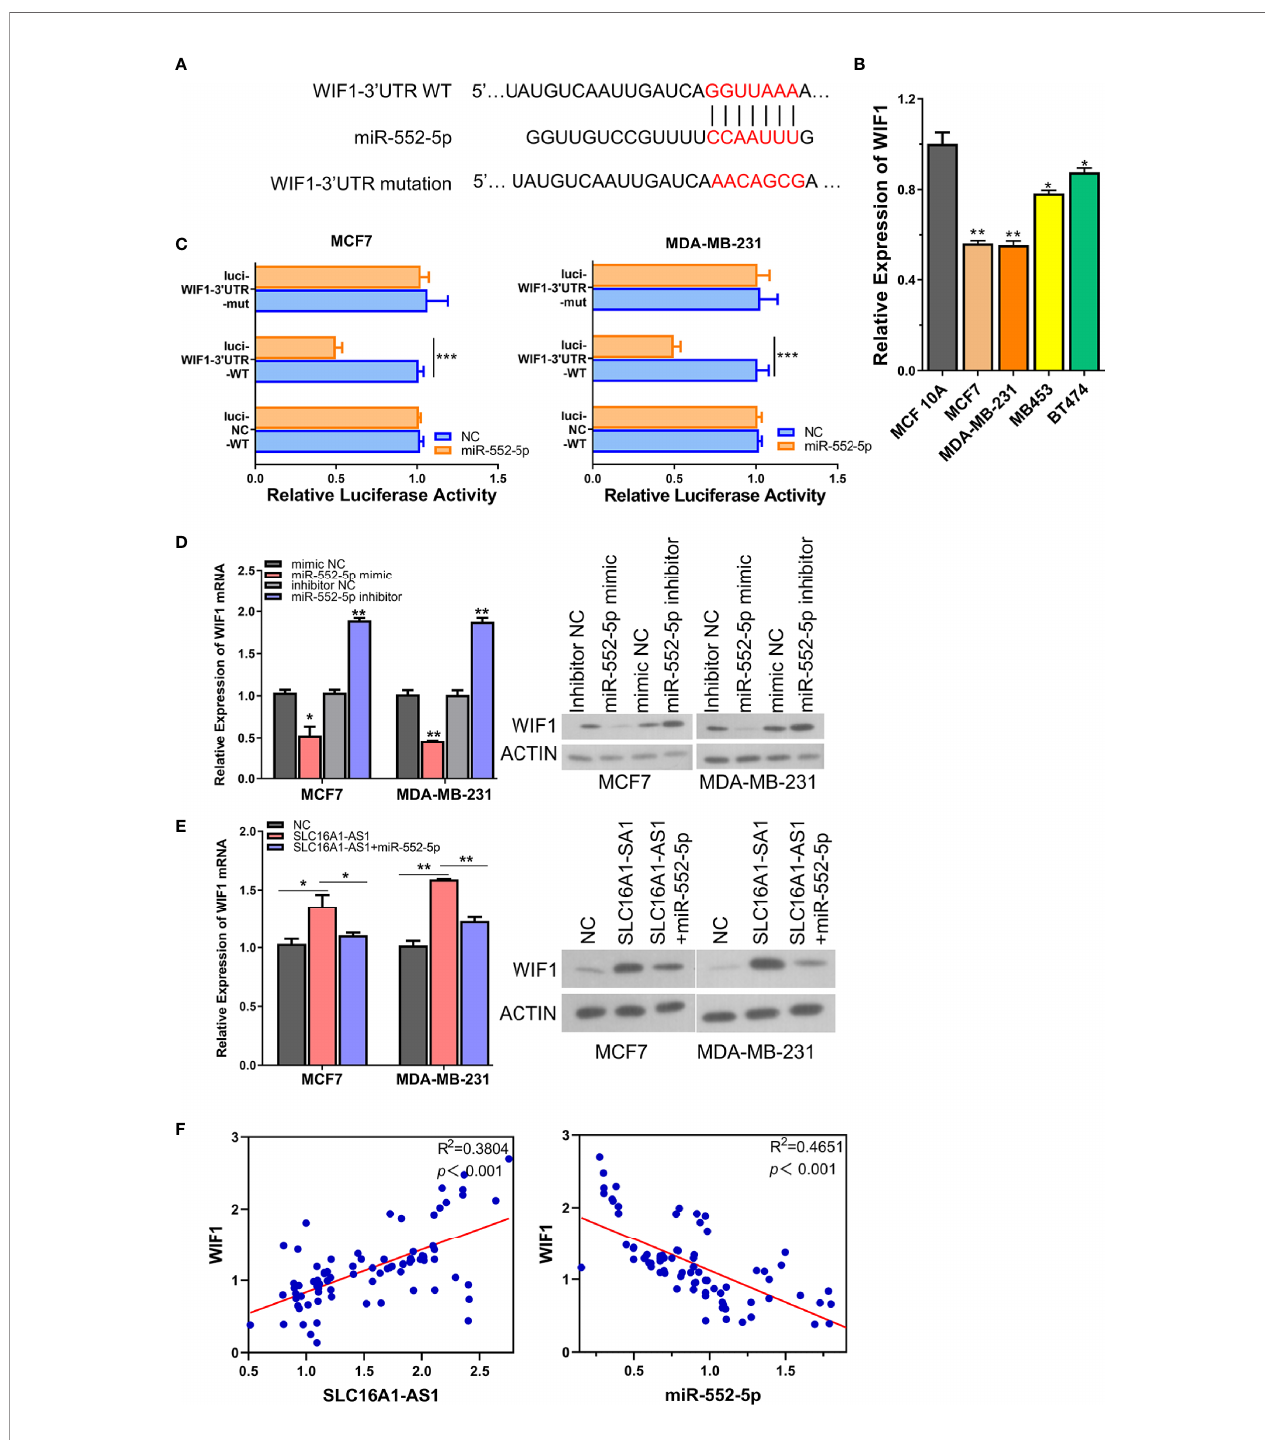
FIGURE 5 | SLC16A1-AS1 increases WIF1 expression via sponging miR-552-5p. (A) Illustration of the prospective binding sites of miR-552-5p in WIF1 3 ′ -UTR predicted with miRanda (http://www.microrna.org/). (B) mRNA expression of WIF1 was signi fi cantly lower in BC cells (MDA-MB-231 and MCF7) than in normal mammary gland epithelial cells (MCF 10A) analyzed by qRT-PCR. (C) Dual-luciferase activities in MDA-MB-231 and MCF7 cells with negative control (NC), wild type (WT), or mutated (mut) reporter of WIF1 3 ′ -UTR with miR-552-5p or without (NC) miR-552-5p mimics. (D) mRNA and protein expressions of WIF1 in MCF7 and MDA-MB-231 cells after miR-552-5p was silenced (miR-552-5p inhibitor) or overexpressed (miR-552-5p mimics). (E) mRNA (left panel) and protein expressions (middle and right panels) of WIF1 in SLC16A1-AS1 overexpressed in MDA-MB-231 and MCF7 cells with or without co-transfecting miR-552-5p. (F) Spearman correlation assay of the correlation between WIF1 and SLC16A1-AS1 or miR-552-5p in BC tissues from 80 BC patients (the same specimens used in Figure 1A ). * p < 0.05, ** p < 0.01, *** p <